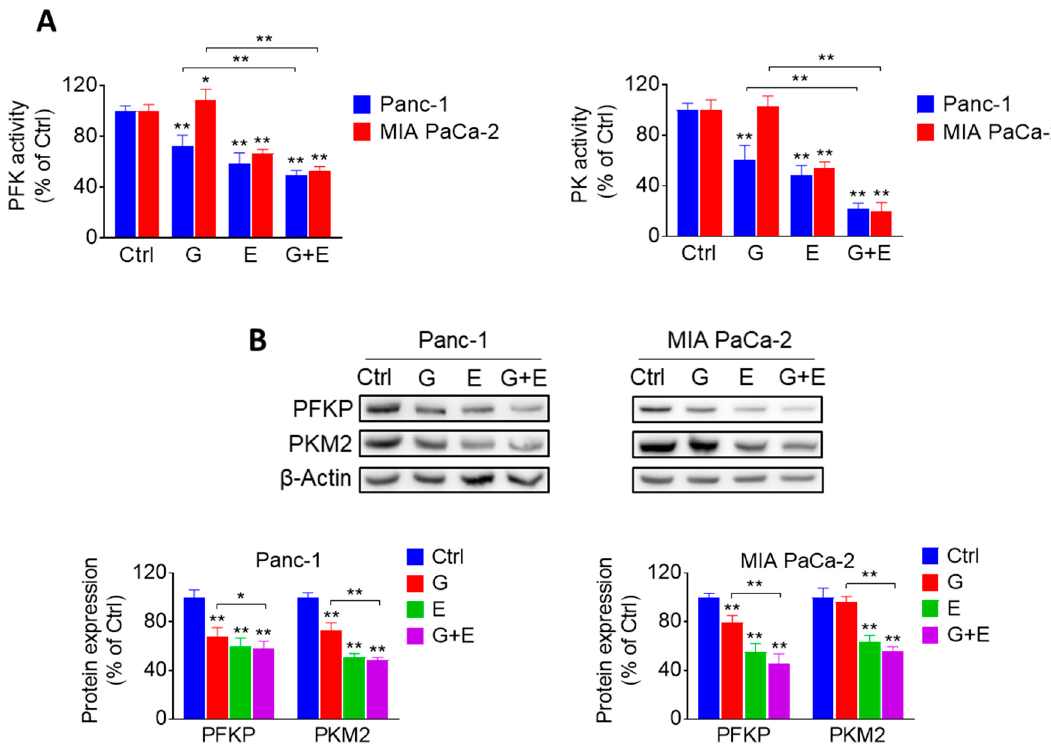
Figure 7. EGCG plus gemcitabine inhibit glycolysis. ( A ) The activity of PFK and PK was determined in Panc-1 and MIA PaCa-2 cells treated with 40 µ M EGCG (E), 20 nM gemcitabine (G), or both (G + E) for 24 h. Results are expressed as a percentage of control. * p < 0.05, ** p < 0.01 vs. control. ( B ) Immunoblots for PFKP and PKM2 in total cell protein extracts from Panc-1 and MIA PaCa-2 cells treated with EGCG (E), gemcitabine (G), or both (G + E) for 12 h. Loading control: β -Actin. Bands were quantified and results are expressed as a percentage of control. * p < 0.05, ** p < 0.01 vs. control.